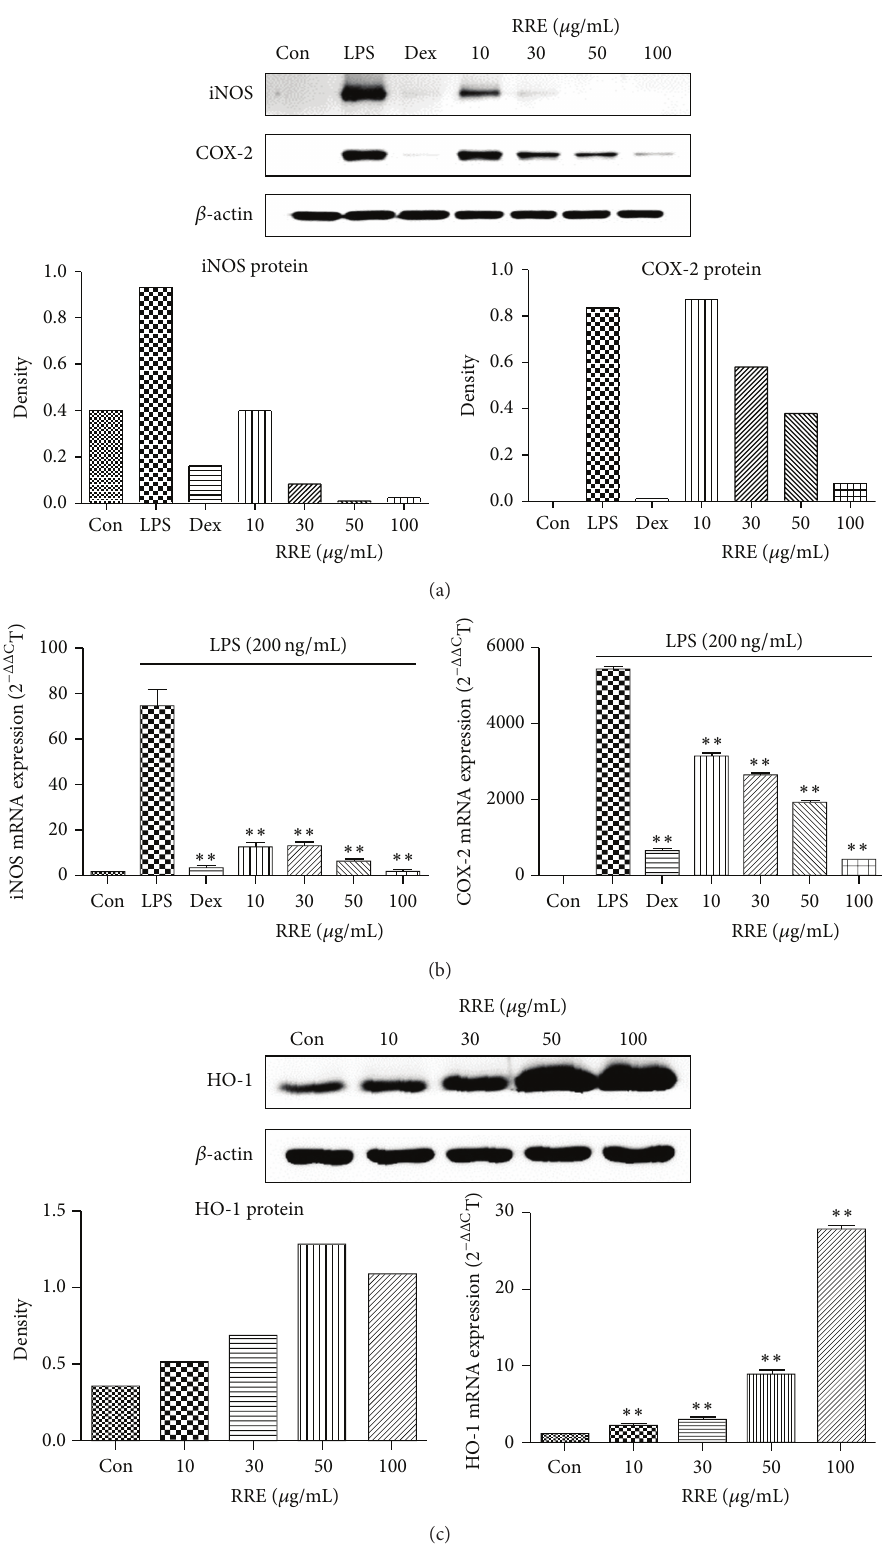
Figure 3: Effects of RRE treatment on the expression of (a) cellular proteins iNOS and COX-2, (b) their mRNAs, and (c) HO-1 in RAW 264.7 cells. Cells were treated with (a, b) LPS alone or with LPS and RRE for 24 h and (c) RRE alone for 6h. 𝛽 -actin served as a control. Results are representative of three independent experiments. ∗∗ 𝑝 < 0.001 was calculated from comparing with LPS-stimulation